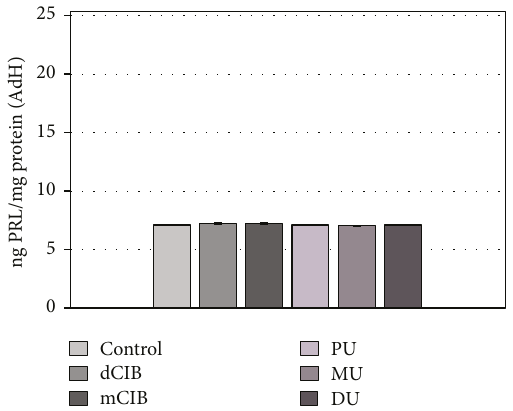
Figure 5: E ff ects of EDC on PRL release in normal rat AdH cultures, in vitro . Mean (PRL/prolactin/level) ± SEM. The mean and SEM are calculated from n = 12 . Abbreviations: dClB=1,4- dichlorobenzene: 0.1ng/ml; mClB =chlorobenzene mix: 0.1ng/ml; PU =phenuron: 10 − 6 M; MU =monuron: 10 − 6 M; DU =diuron: 10 − 6